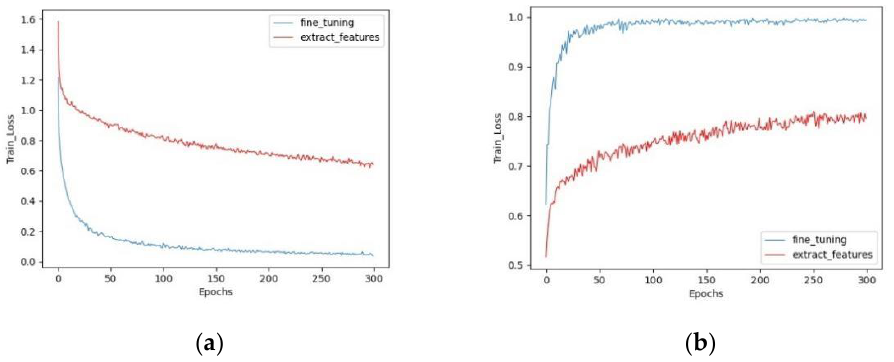
Figure 13. Accuracy and loss curve of MobileNetV3 in two different train methods, the blue line represents fine-tuning and the red line represents feature transfer. ( a ) Training loss (train_loss). ( b ) Validation accuracy (val_acc).